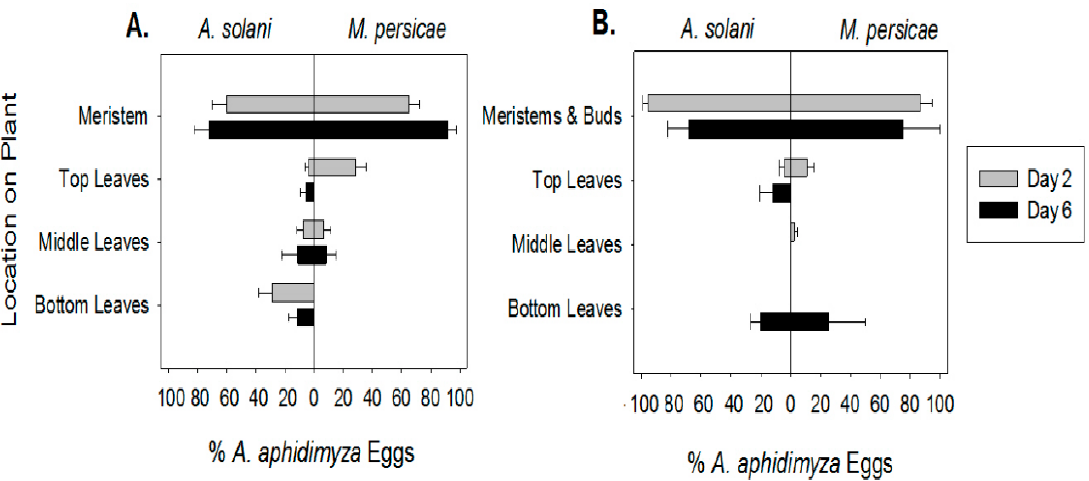
Figure 2. Within-plant distribution (average % ± SE) of Aphidoletes aphidimyza eggs on Myzus persicae or Aulacorthum solani 2 days and 6 days after release. ( A ) Oviposition on vegetative plants; ( B ) oviposition on budding plants.